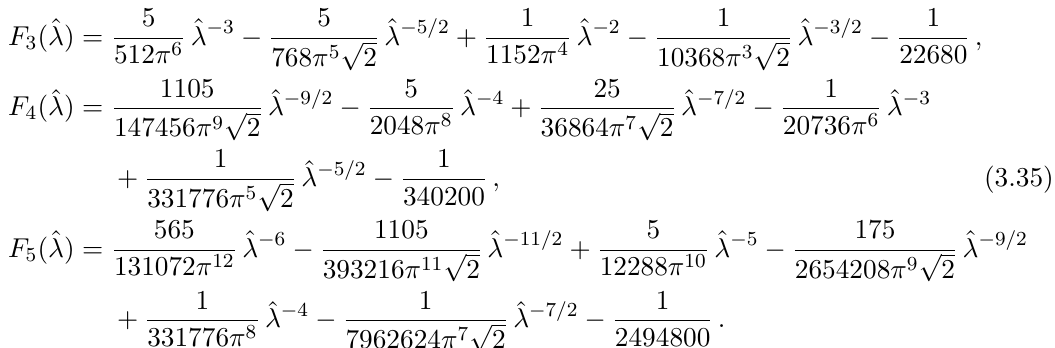
< λ ≤ 30 (left) and 1 < λ ≤ 1 24 24 3